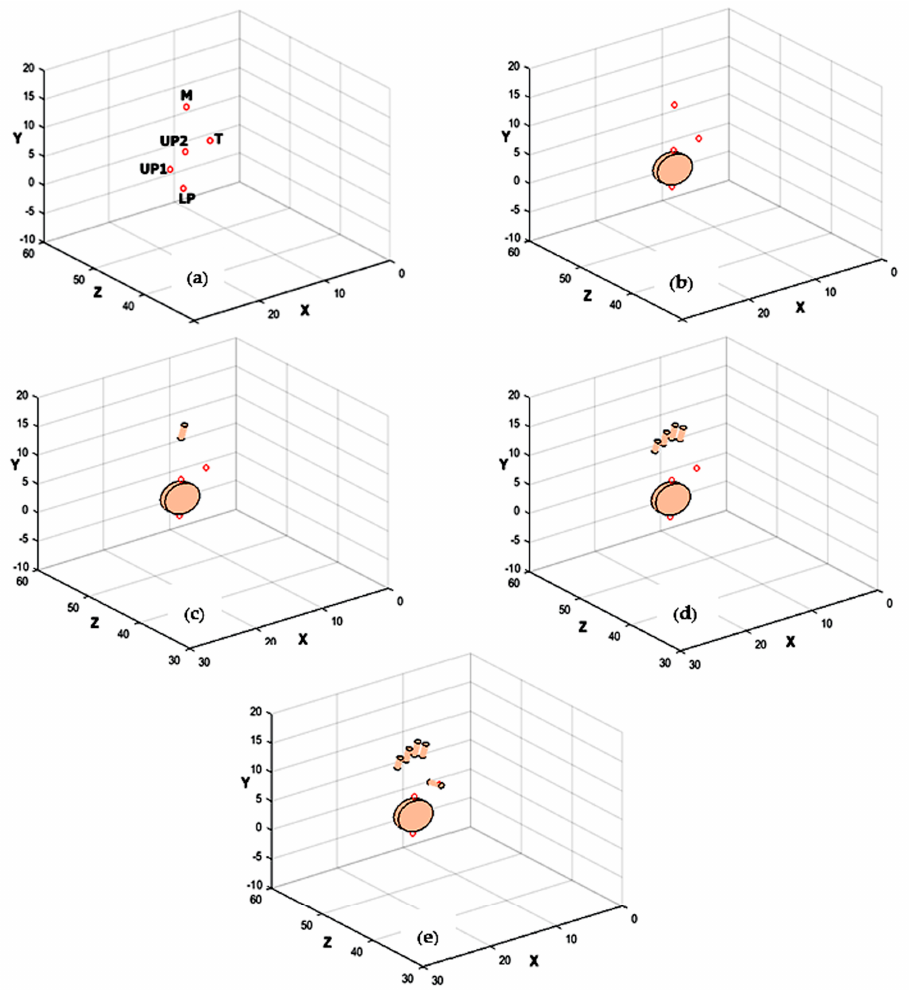
Figure 8. 3D Rendering of hand ( a ); calculated LED positions ( b ); palm plane reconstructed using Three LEDs on Palm ( LP , UP 1, and UP 2) ( c ); middle finger reconstructed with M LED ( d ); index, ring, and little fingers reconstructed using the properties of M LED ( e ); thumb reconstructed with T LED.